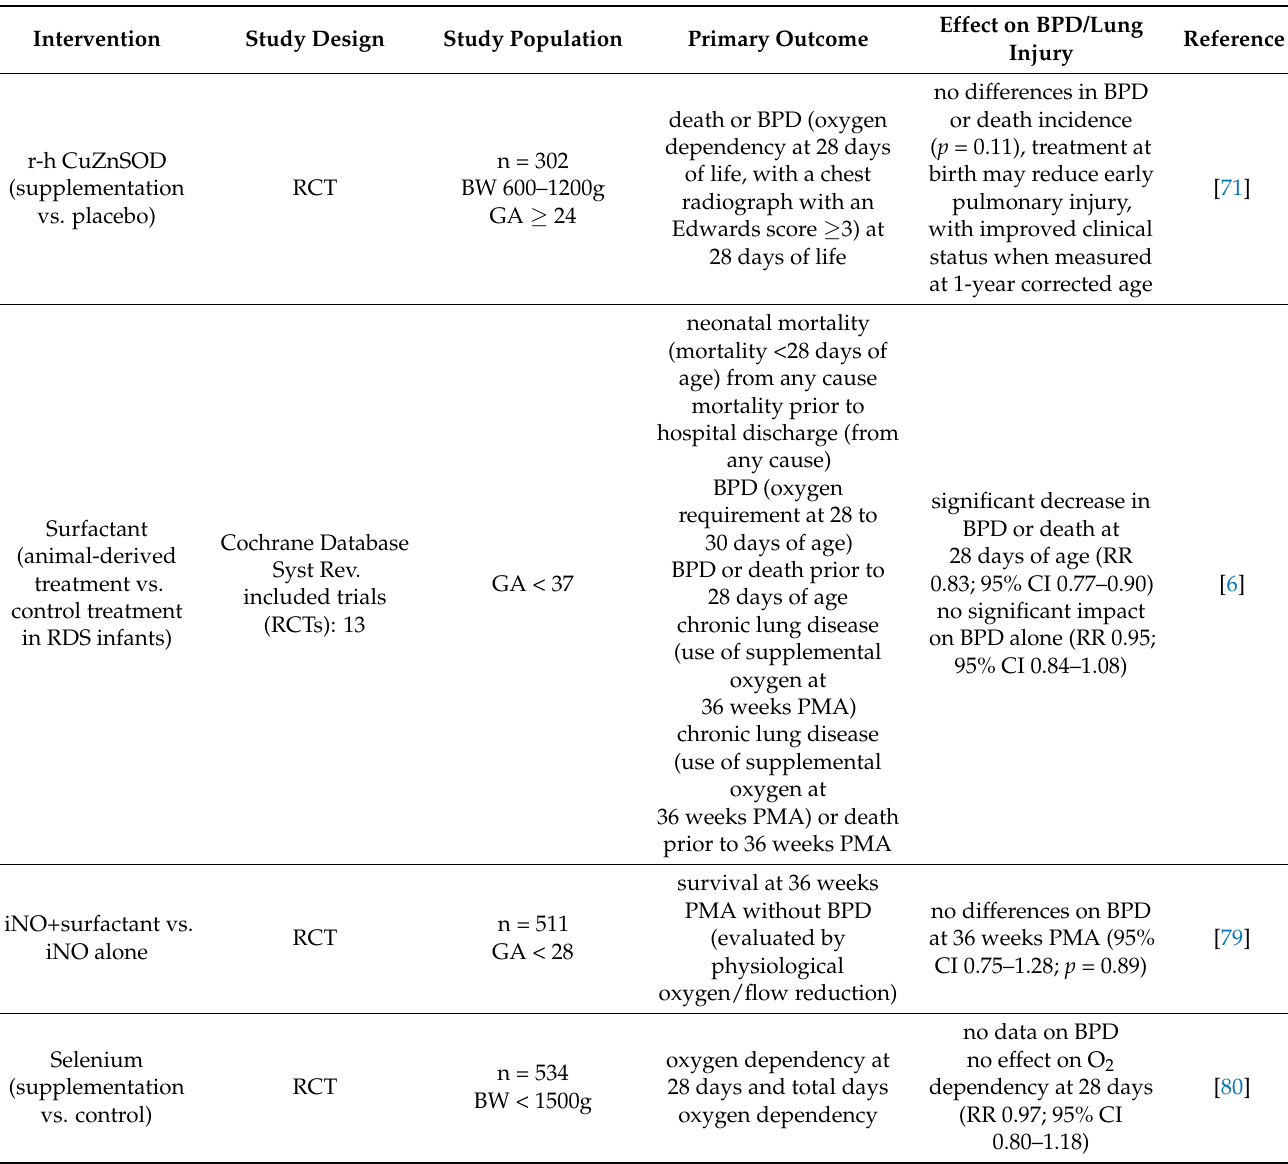
Table 2. Clinical approaches to prevent ROS-induced lung injury and BPD—enzymatic therapy and trace elements as enzyme